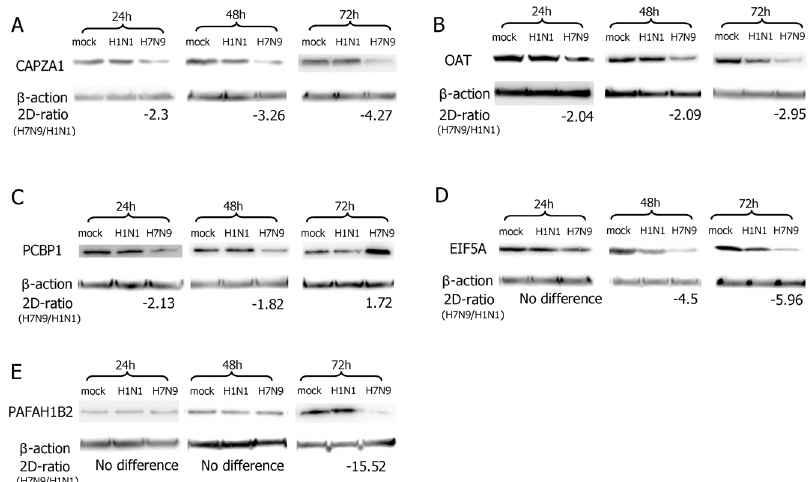
Fig 4. Results of western blot analysis. The differentially expressed proteins of CAPZA1 (A), OAT (B), PCBP1 (C), EIF5A (D), PAFAH1B2 (E) in H7N9- and H1N1pdm09-infected A549 cells at 24, 48 and 72hpi as well as time-matched mock-infected cells were confirmed by western blot analysis.